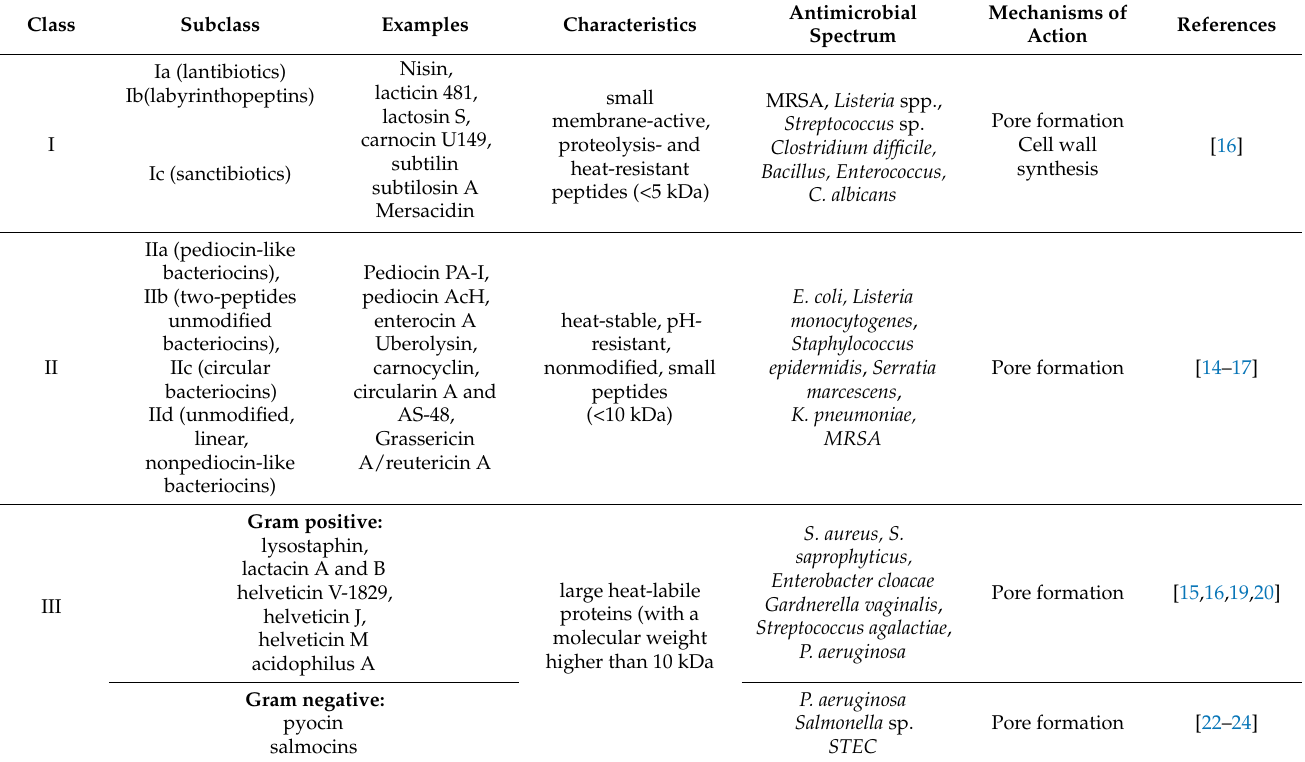
Table 1. Bacteriocin classes’ characteristics, spectrum, and mode of